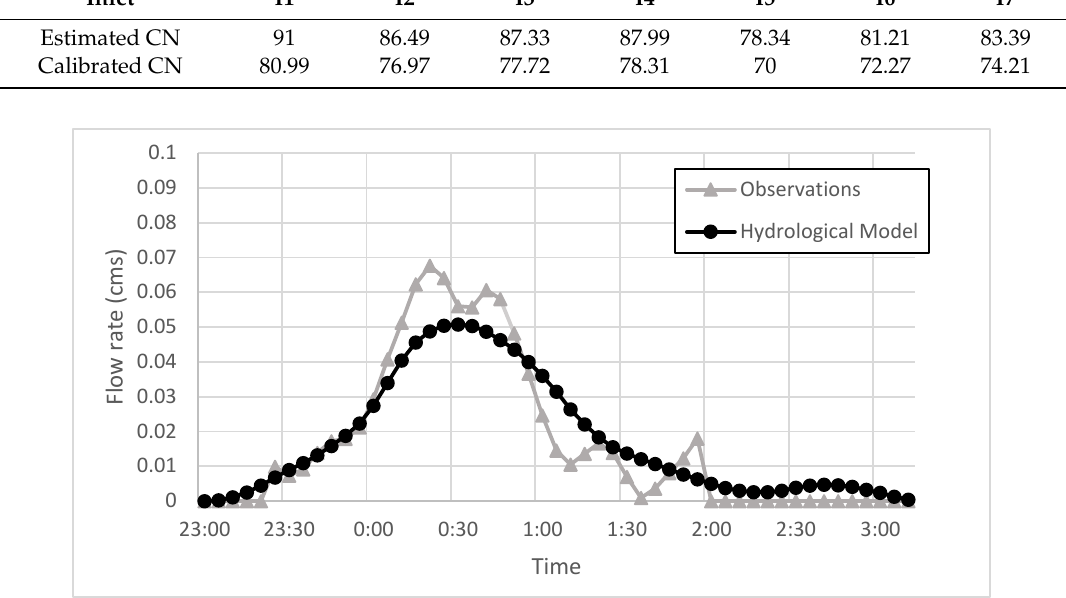
Figure 2. Modeled and observed hydrographs at I5 inlet of storm event on 28 May 2007.